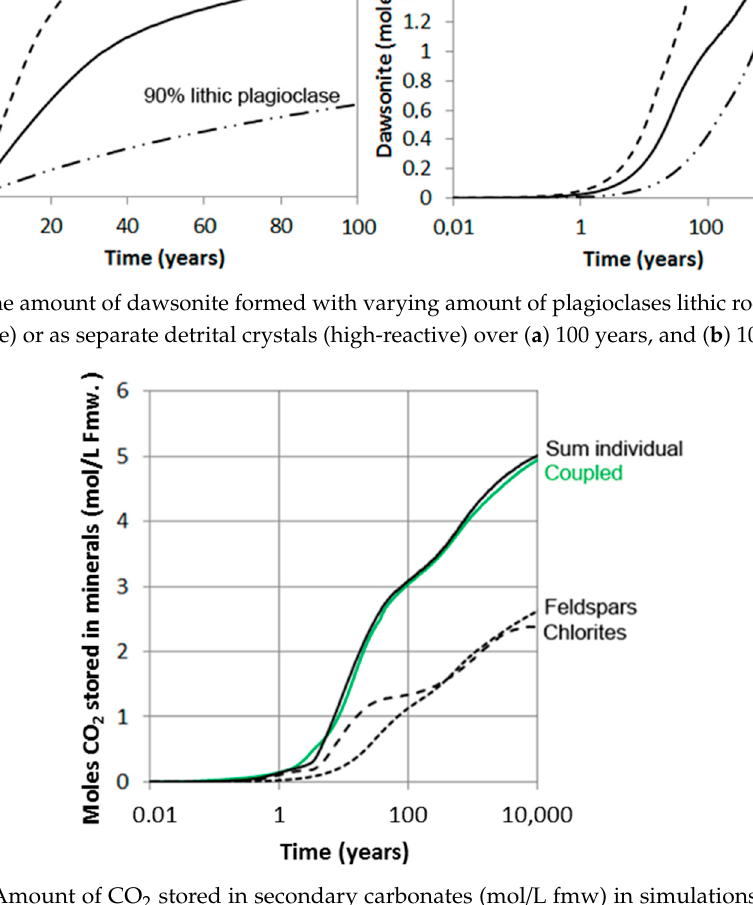
Figure 10. Amount of CO 2 stored in secondary carbonates (mol / L fmw) in simulations only taking into account either feldspars or chlorites, and compared to the results in coupled simulations taking into account both feldspars and chlorites. No / little di ff erence suggests that pH is the same in both cases. The motivation to run separate simulations is to save time in more complex large-scale reactive transport simulations.